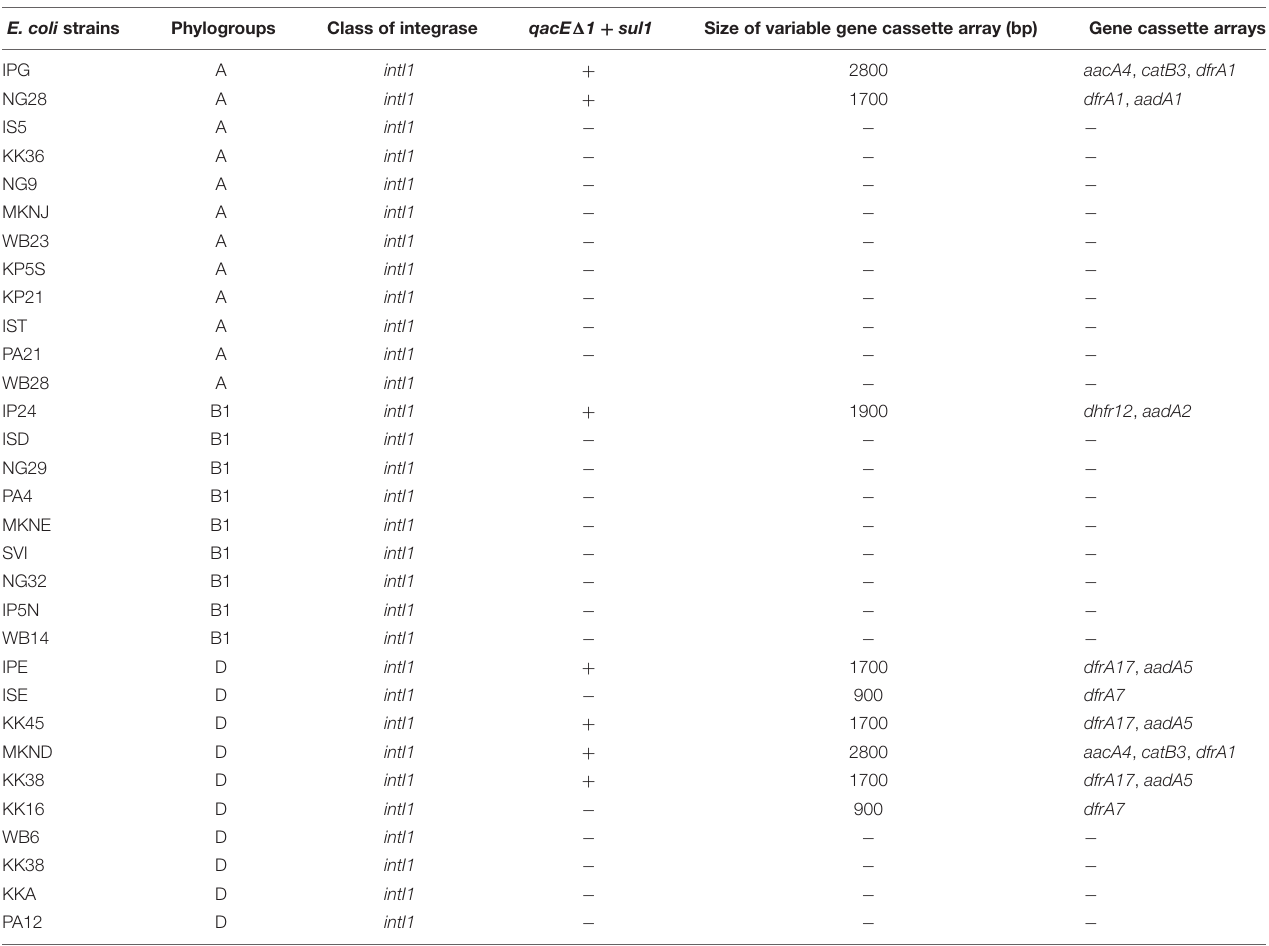
TABLE 2 | Characteristics of class 1 integrons of Indian aquatic E. coli